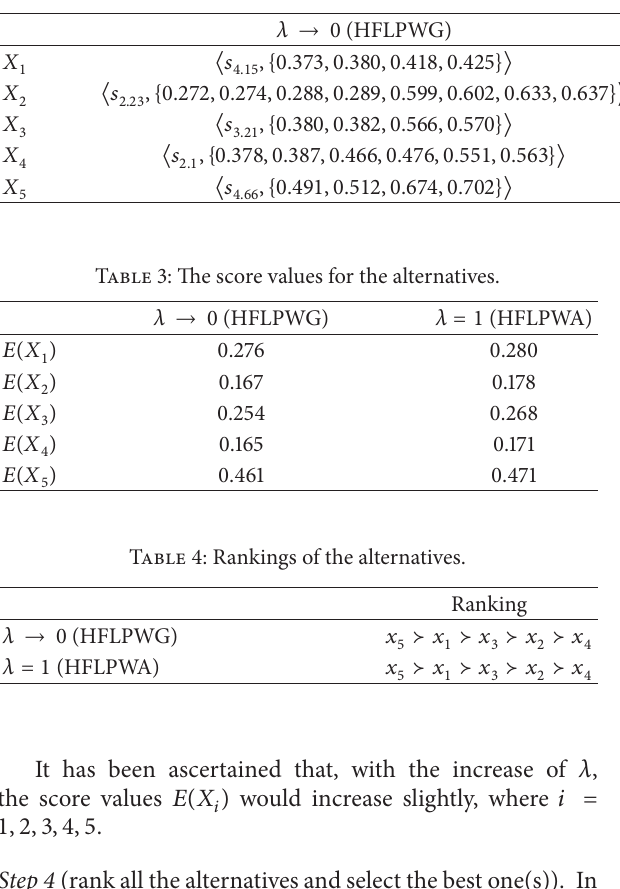
Table 2: The aggregation results by utilizing the HFLGPWA operator.